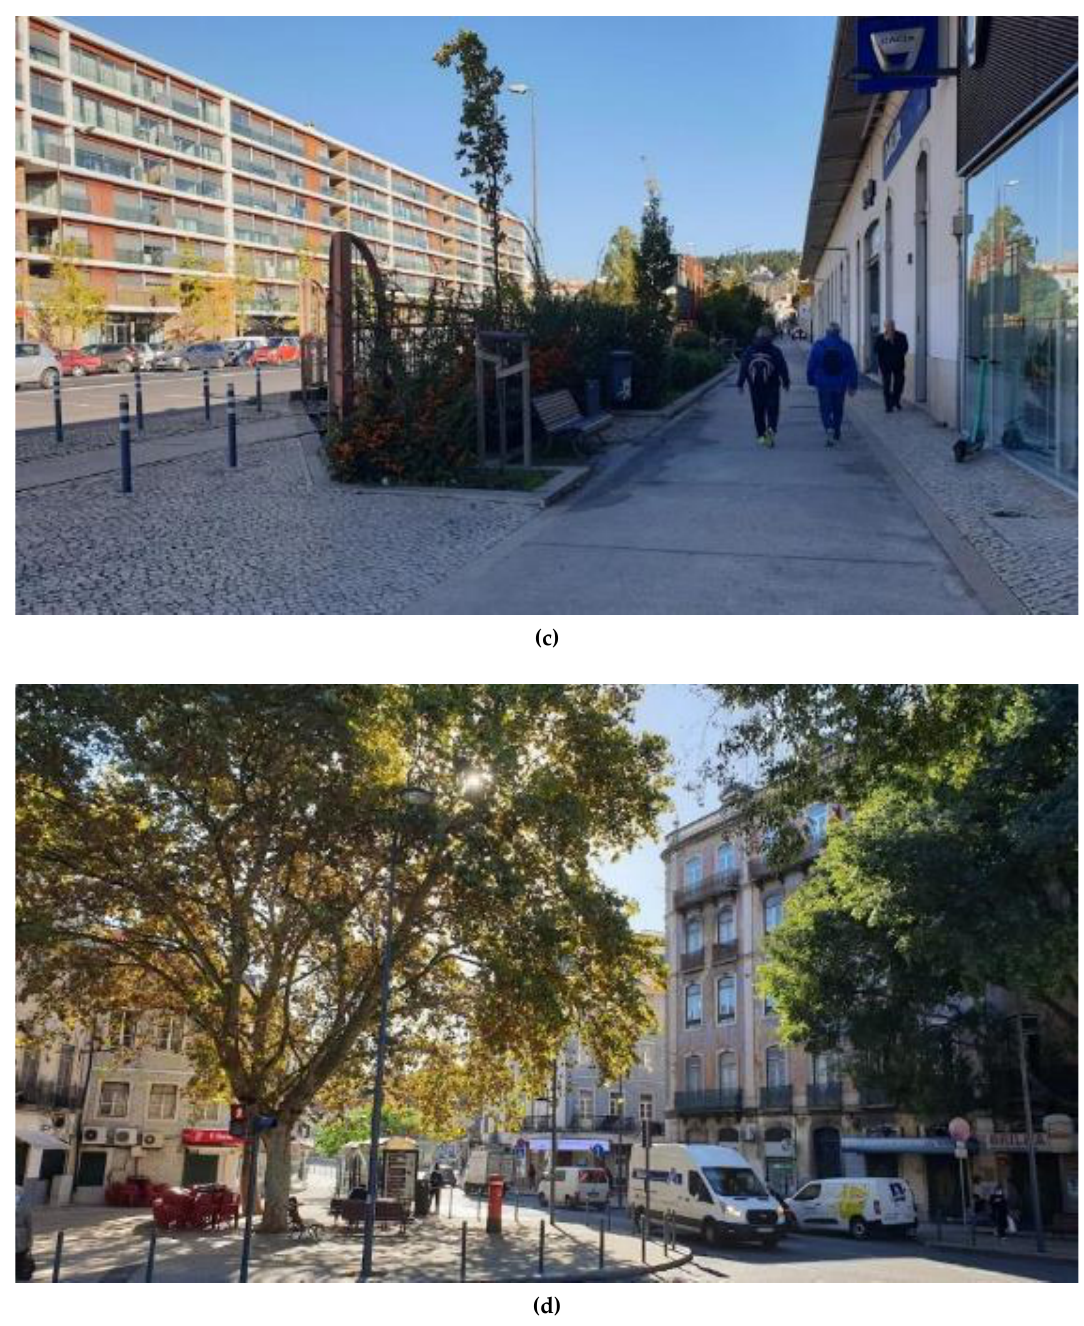
Figure 6. Alcântara Valley, November 2021. Source: Sofia Morgado. ( a ) Alcântara Green Corridor with the Tagus, towards the south, from the Aqueduct; ( b ) Alcântara Green Corridor and Cam- polide Train Station, new works, towards the north, from the Aqueduct; ( c ) Alcântara XXI, ( d ) Alcântara main street, former city gate through the Bridge, towards the city mid-19th century Intra- muros.